Question: Looking at the figure, what chart type is it?
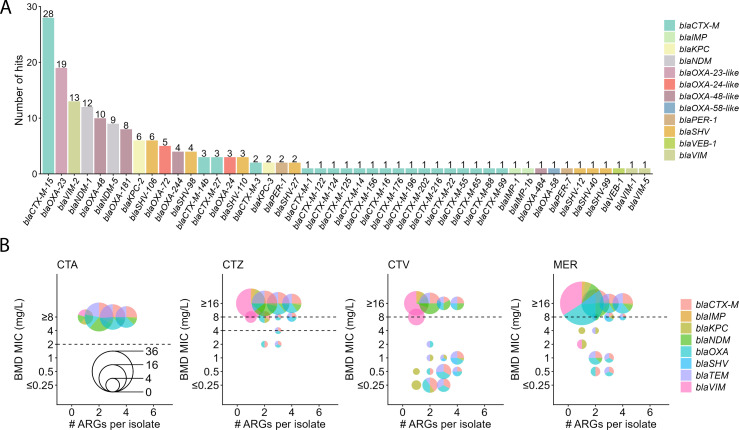
Answer: histogram